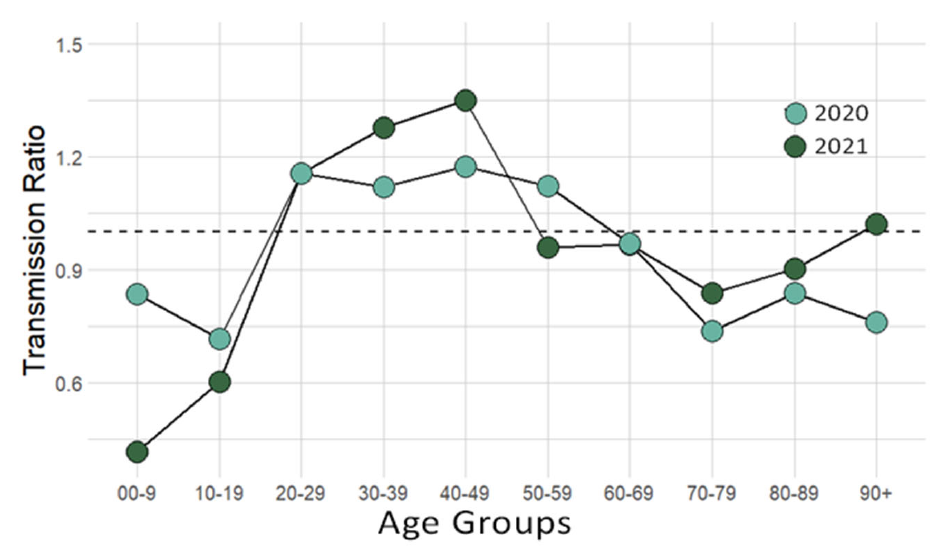
Figure 4. Transmission ratio for the age group in 2020–2021.